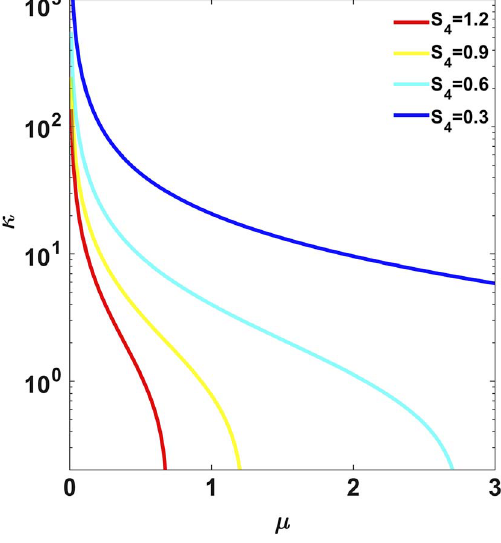
Fig. 6. Relationship of fading coef fi cients j - l for distinct values of S 4 . As the curves describes, j decreases as l